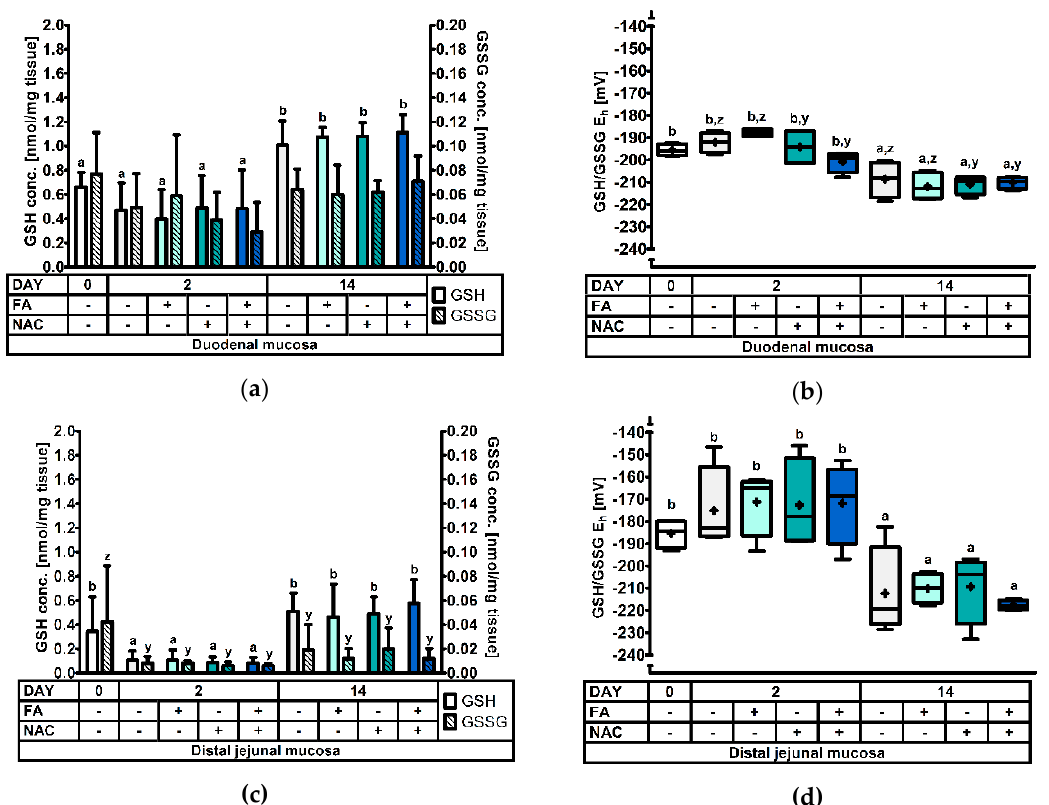
Figure 2. The glutathione redox system in the small intestinal mucosa of piglets at 0d, 2d, and 14d post-weaning (DAY), either ad libitum fed (FA − ) or fasted (FA+) the first 2d post-weaning, and either provided standard drinking water (NAC − ) or water supplemented with 200 mg/L N -acetyl cysteine (NAC + ) during the first 14d post-weaning. Results are presented as least squares means with SD. Significance levels of main e ff ects and interaction terms are presented in Table 3: ( a,c ) Glutathione (GSH) and glutathione disulphide (GSSG) concentrations in the duodenal mucosa ( a ) or the distal jejunal mucosa ( c ). a,b And y,z respectively represent the e ff ect of DAY on GSH and GSSG concentrations across other factors ( p ≤ 0.05); ( b,d ) Glutathione redox status (GSH / GSSG E h ) in the duodenal mucosa ( b ) or the distal jejunal mucosa ( d ). a,b and y,z respectively represent the e ff ect of DAY and NAC across other factors ( p ≤ 0.05).